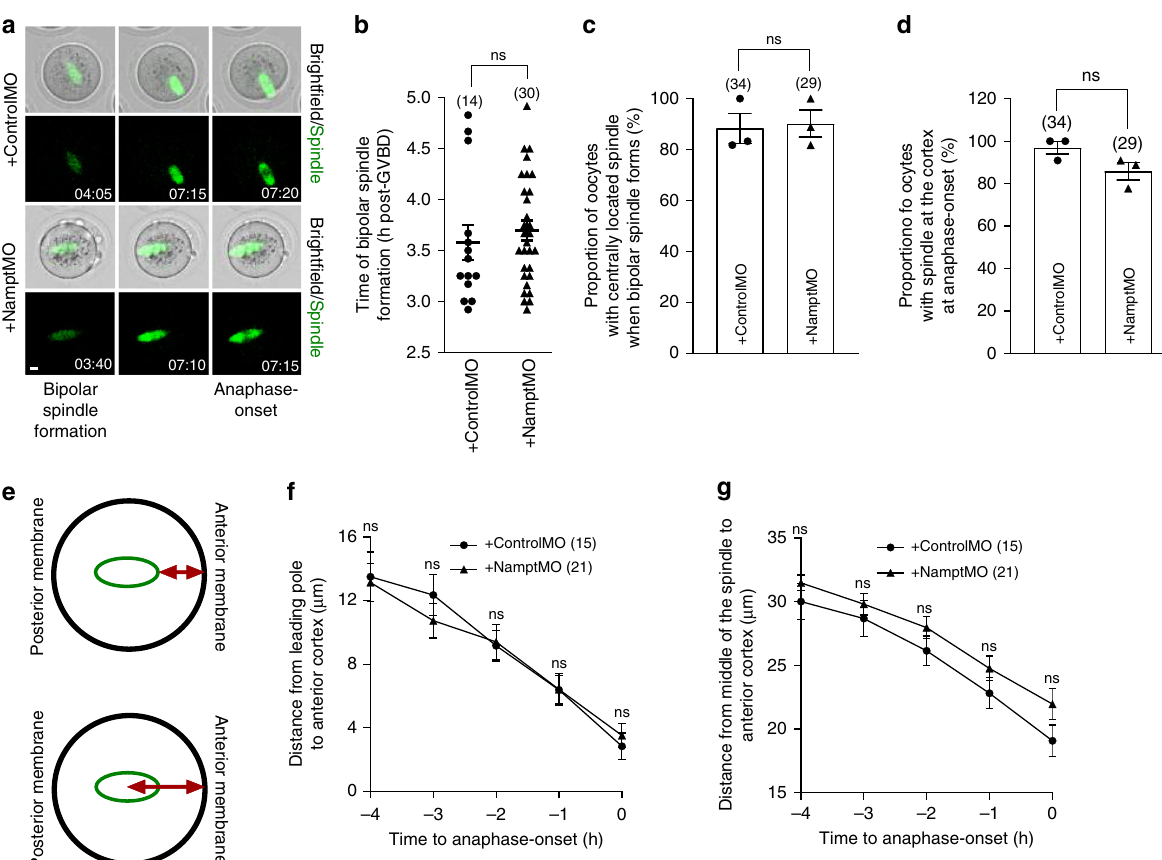
Fig. 2 Intact pre-anaphase-spindle migration following Nampt-depletion. a Shown are panels comprised of selected bright fi eld and fl uorescence frames from representative time-lapse series of oocytes with SiR-tubulin-labelled spindles. Note that in both ControlMO- and NamptMO-injected oocytes, the bipolar spindle is located close to the oocyte centre when fi rst formed and then migrates to the cortex prior to anaphase-onset. Times are shown as h: min relative to GVBD. Scale bar, 10 μ m. Representative images from three independent experiments are shown. b Timing of bipolar spindle formation. c Proportion of oocytes with spindles located in the centre at the time of bipolar spindle formation. d Proportion of oocytes with spindles at the cortex when anaphase occurred. e Schematics depicting the measurements that were plotted in f and g . f Changes in leading pole-to-cortex distance over time. g Changes in spindle centre-to-cortex distance over time. Oocyte numbers are shown in parenthesis from three independent experiments ( b – d , f and g ). Data in graphs are presented as the mean ± SEM. Data points are shown in c and d . P- values, ns denoted P > 0.05. Statistical comparisons were made using either two-tailed Student ’ s t -test in b – d or two-way repeated measures ANOVA in f and g . See also Supplementary Movies 2 and 3. Source data are provided as a Source Data fi